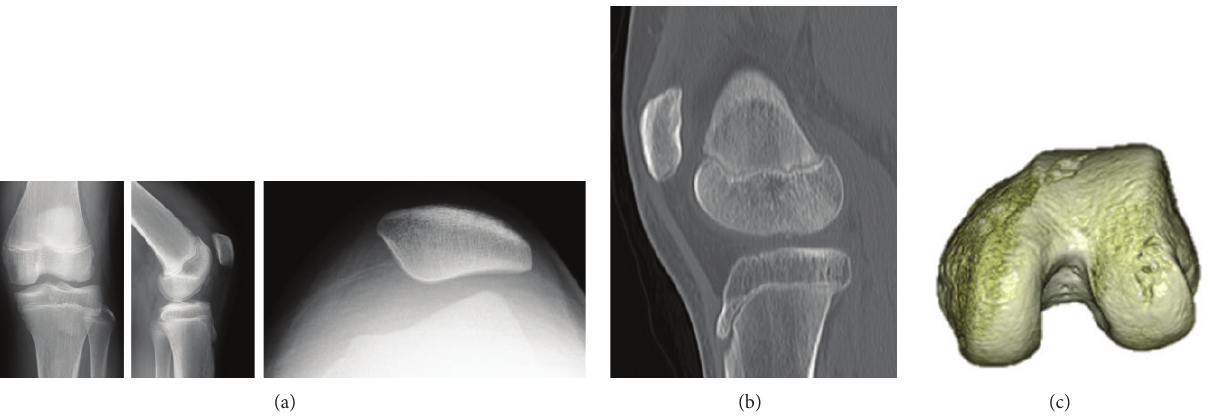
Figure 2: Findings in Patient 2. (a) Plain radiography, showing bone avulsion between the condyles. (b) Sagittal view of plain CT, showing an irregular 10 × 15-mm subchondral bone on the weight-bearing surface of the lateral femoral condyle. (c) 3D-CT, clearly showing the morphology of the osteochondral injury of the lateral femoral condyle.